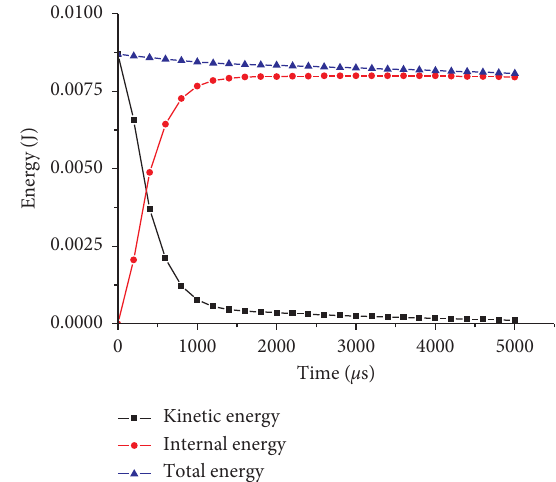
Figure 6: Energy time history at a velocity of